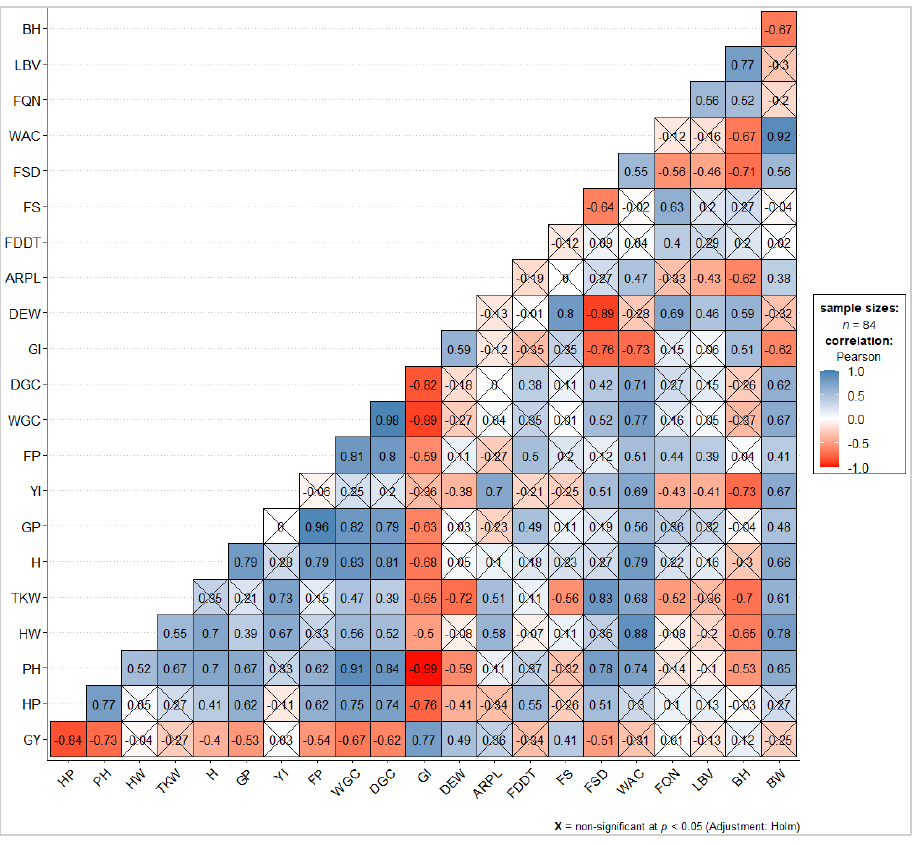
Figure 2. Correlation matrix of all pairs of variables. Correlation coefficients on the principal diagonal are not shown. Flagged coefficients are not significant (at 5% significance level). Negative and positive correlations are displayed in red and steelblue, respectively, while white colour represents no association between pairs of variables. Colour intensity is proportional to the correlation coefficients values, as reported in the legend. GY, grain yield; HP, heading period; PH, plant height; HW, hectolitre weight; TKW, thousand kernel weight; H, hardness; GP, grain protein; YI, yellow index; FP, flour protein; WGC, wet gluten content; DGC, dry gluten content; GI, gluten index; DEW, deformation energy W; ARPL, alveograph ratio P/L; FDDT, farinograph dough development time; FS, farinograph stability, FSD, farinograph softening degree; WAC, water absorption capacity; FQN, farinograph quality number; LBV, loaf bread volume; BH, bread height; BW, bread weight.